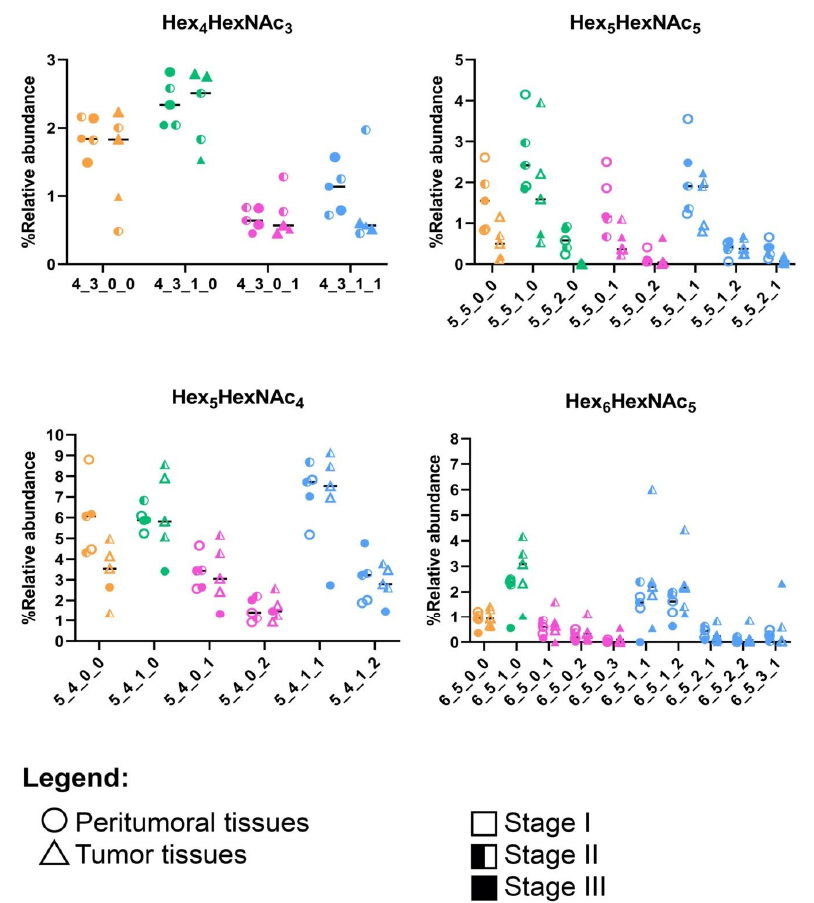
Figure 2. Specific comparison of the most abundant undecorated N ‐ glycan structures and their decorations (e.g., fucosylation and sialylation): Hex 4 HexNAc 3 , Hex 5 HexNAc 4 , Hex 5 HexNAc 5 , and Hex 6 HexNAc 5 . N ‐ glycans are color ‐ coded according to the type: undecorated (orange), fucosylated (green), sialylated (pink), and sialofucosylated (blue). MS/MS fragmentation spectra can be found in Figure S7.